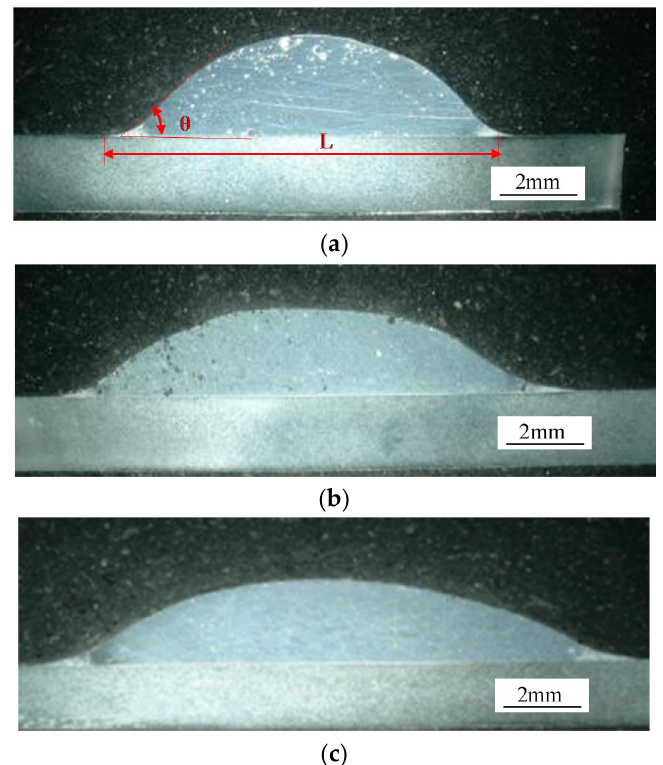
Figure 4. Metallographic cross sections for bead-on-plate brazing at different preheating temperatures. ( a ) Without preheating; ( b ) 100 ◦ C; ( c ) 200 ◦ C.